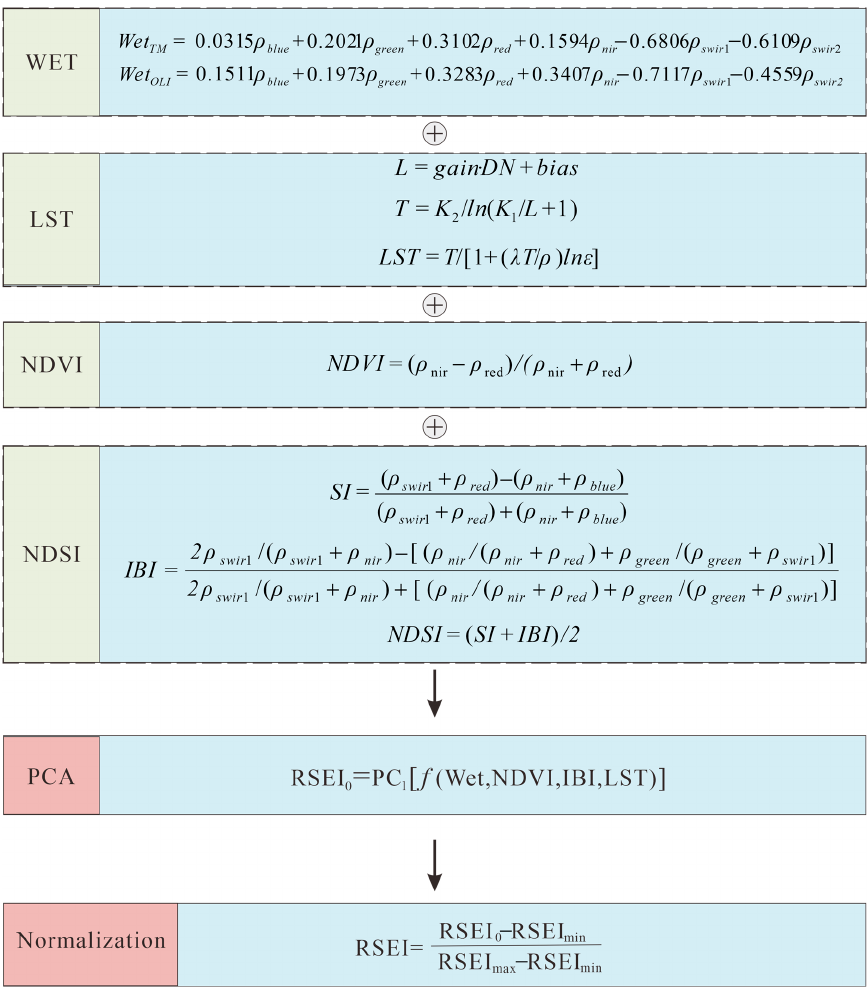
Figure 2. Flow chart of RSEI calculation .